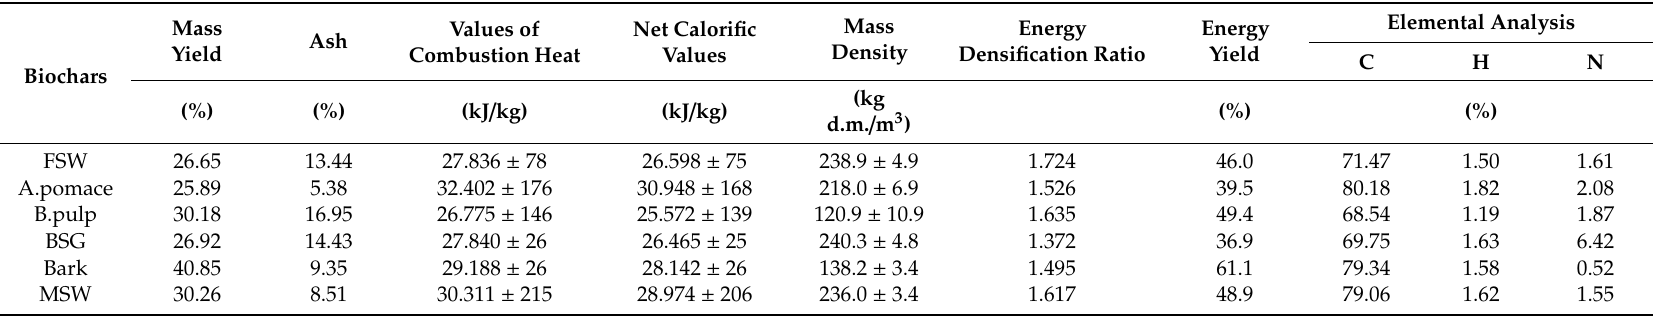
Table 2. Compositional and elemental analysis of biochar, expressed as average values ( ± standard deviation). FSW—flavored spirits production waste (lime,